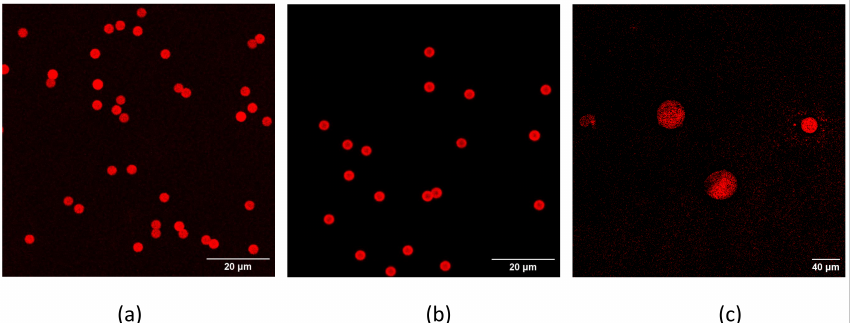
Figure 5. Confocal analysis of fluorescent aptamers bound to beads: DynaEpoxy beads conjugated with a-TC8 labeled with TAMRA ( a ), DynaSA conjugated with a-TC40 TAMRA ( b ), and PureCube Maleimide with a-TC76 TAMRA. Scale bars represent 20 µm in panels ( a , b ), while in ( c ) is referred to 40